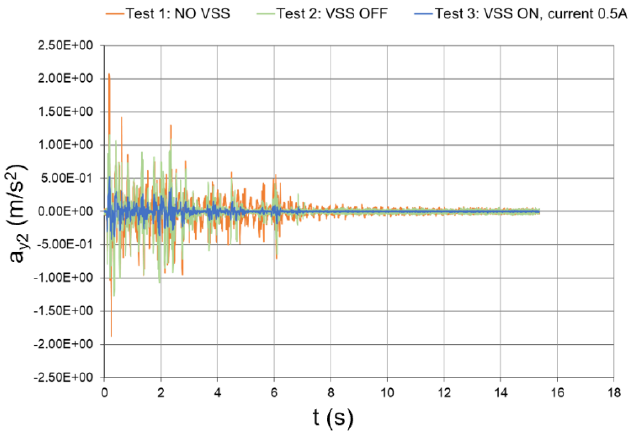
Figure 45. Seismic response, 2nd-floor acceleration with respect to the ground (experimental data).